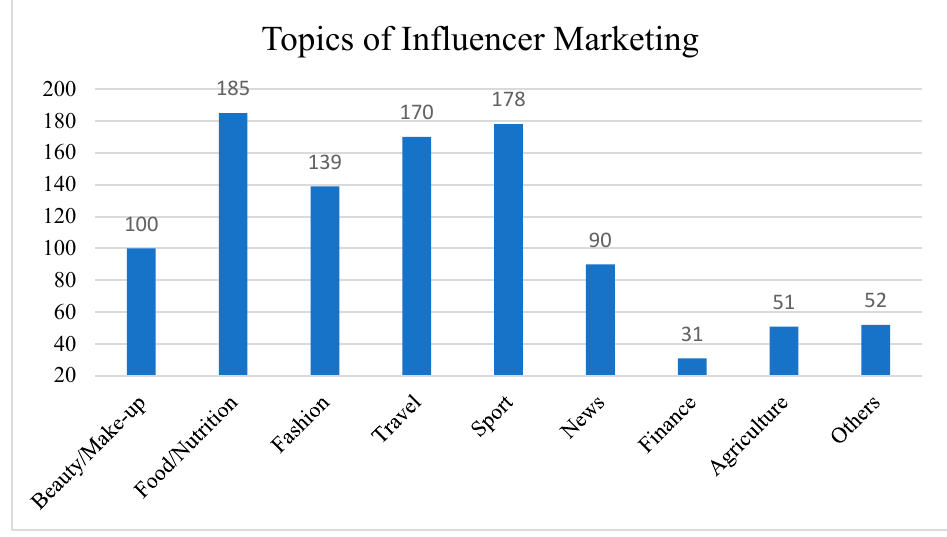
Figure 1. Topics of Influencer Marketing .